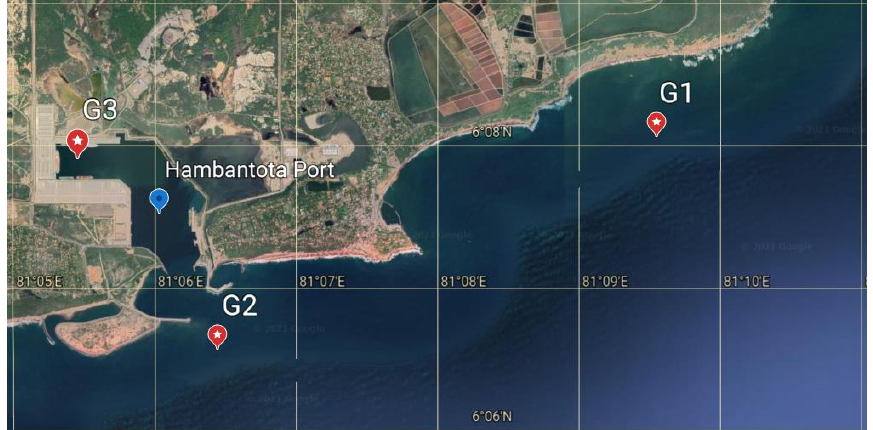
Figure 1. Google Earth screenshot depicting the locations of Hambantota Port and three acoustic waves and current (AWAC) sensors. Sensor G1 is located near the shoreline, approximately 7 km from G2, located near the port entrance. Sensor G3 is deployed inside the harbor. The placements of the three AWAC sensors are depicted as red marks in Figure 1.